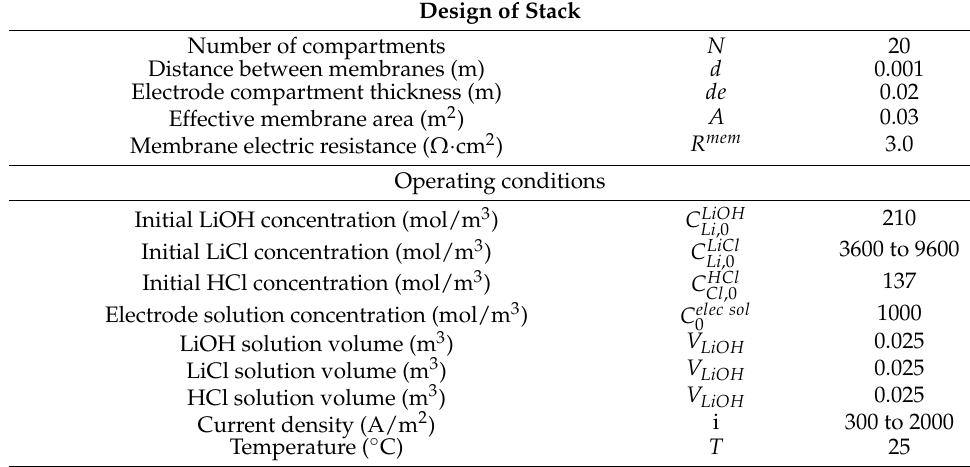
Table 3. BMED stack design parameters and initial operating conditions for parametric